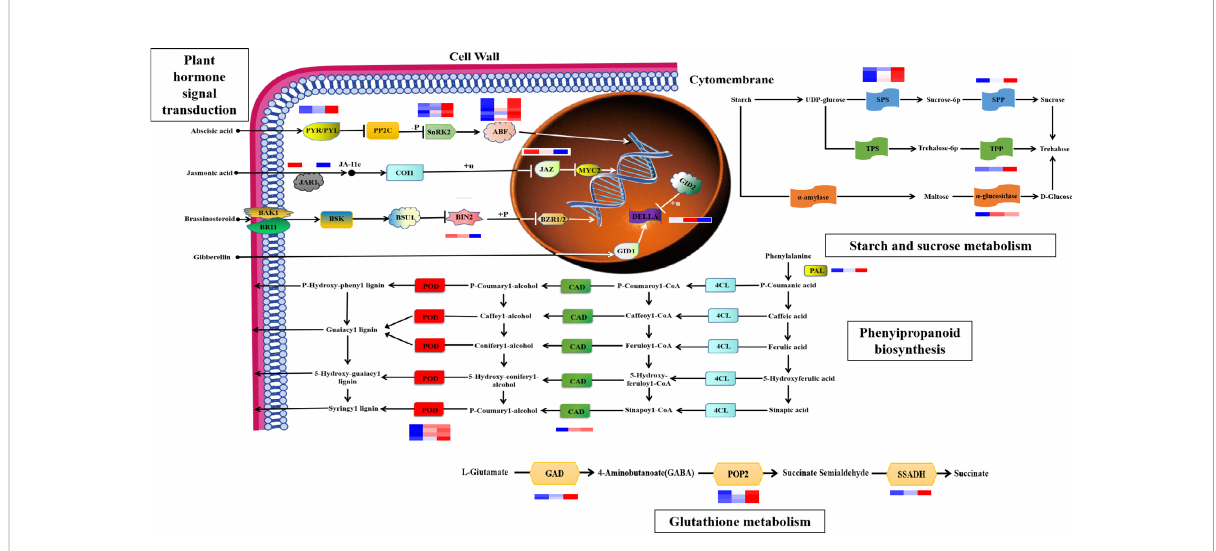
FIGURE 6 The key pathways of the drought stress response in maize. These pathways were “ plant hormone signal transduction ” , “ phenylpropanoid biosynthesis ” , “ starch and sucrose metabolism ” , and “ glutathione metabolism ” .